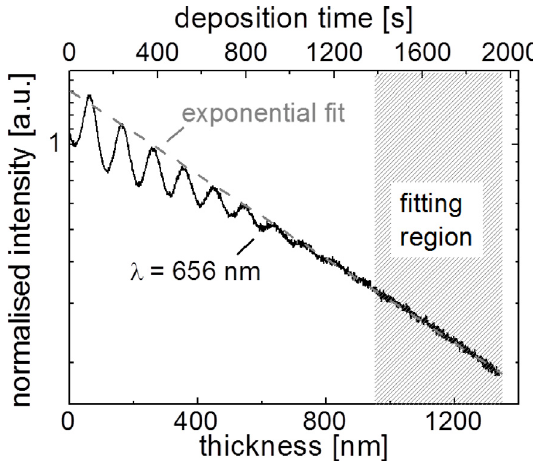
Fig. 2. Transient transmission of the plasma emission line at 656 nm through a growing μ c-Si:H film. An exponential fit function (dashed curve) was applied at the last 400 nm of the μ c-Si:H layer deposition (see gray fitting